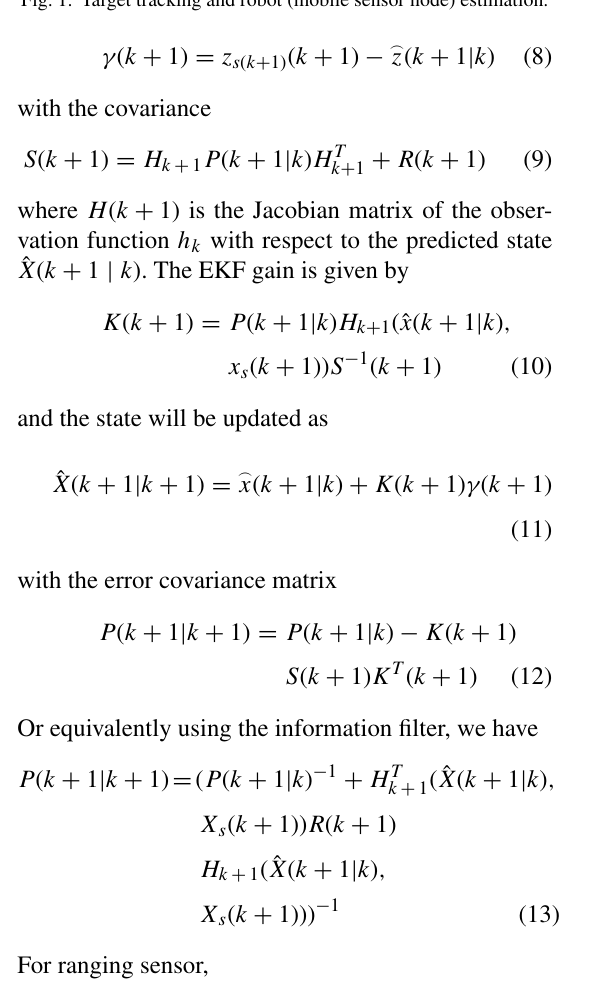
Fig. 1. Target tracking and robot (mobile sensor node)